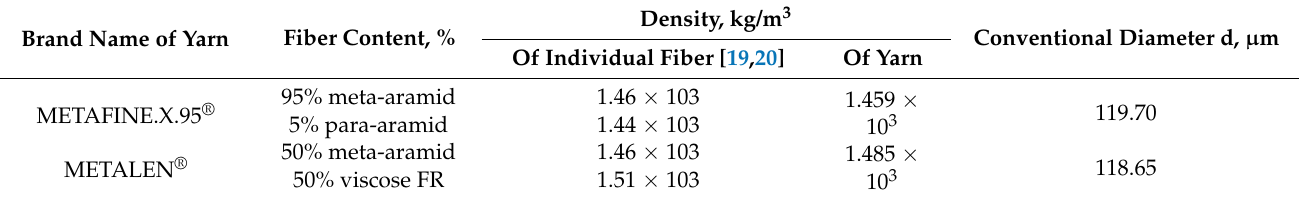
Table 3. The calculated values of the conventional diameters of spun yarns used for production of the knitted